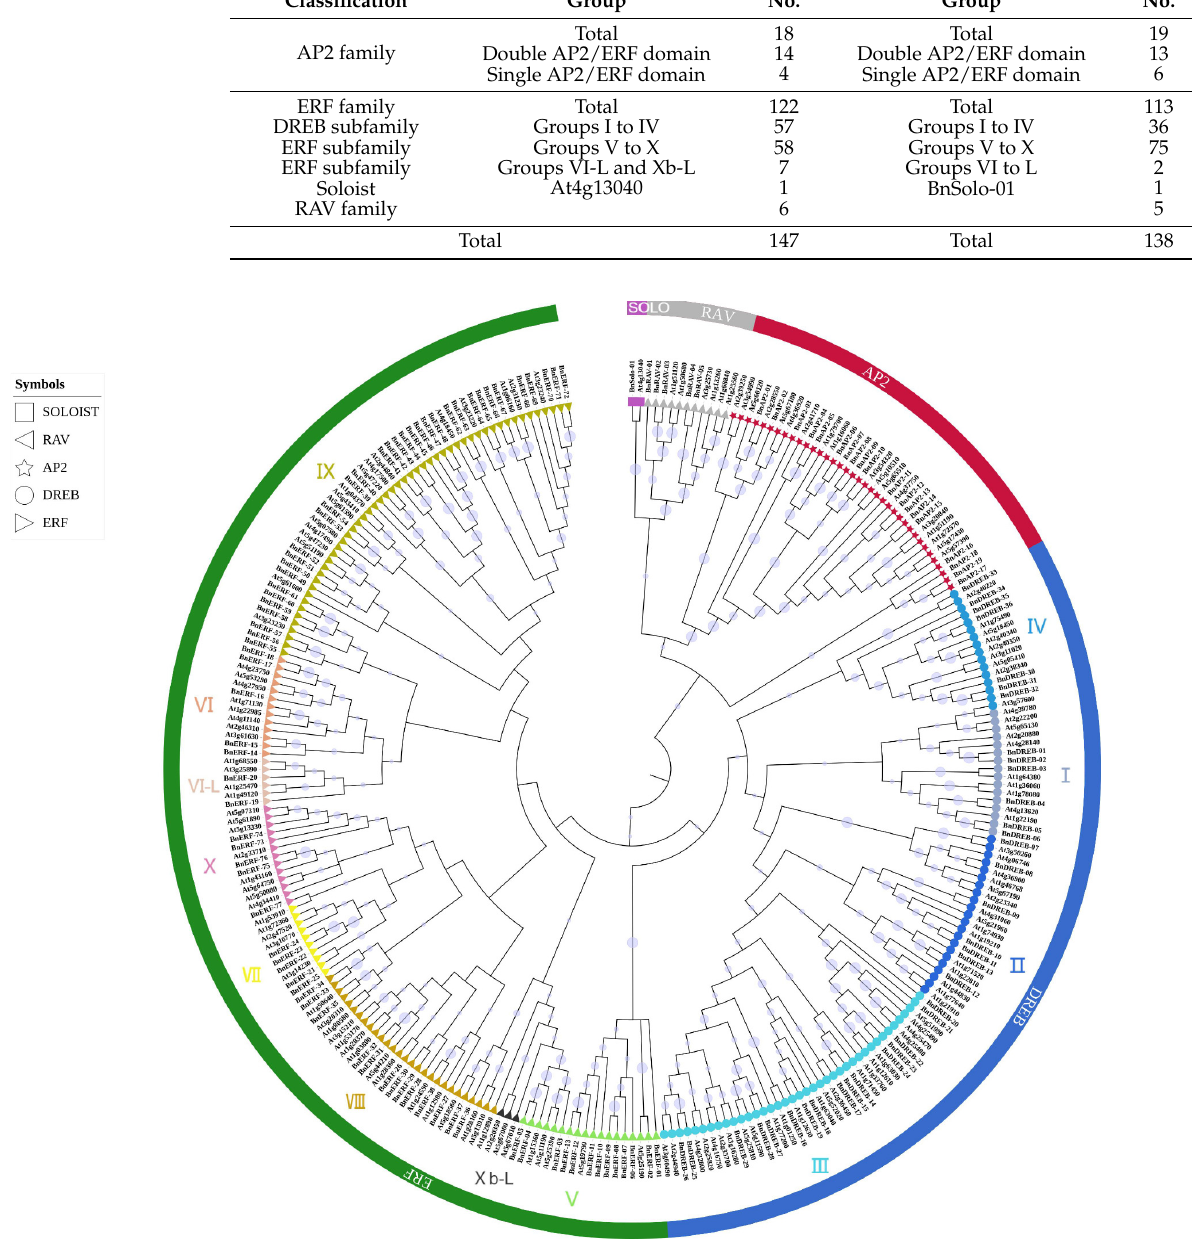
Figure 1. An unrooted phylogenetic tree constructed by the neighbor-joining method using AP2/ERF transcription factor domains in ramie and Arabidopsis .